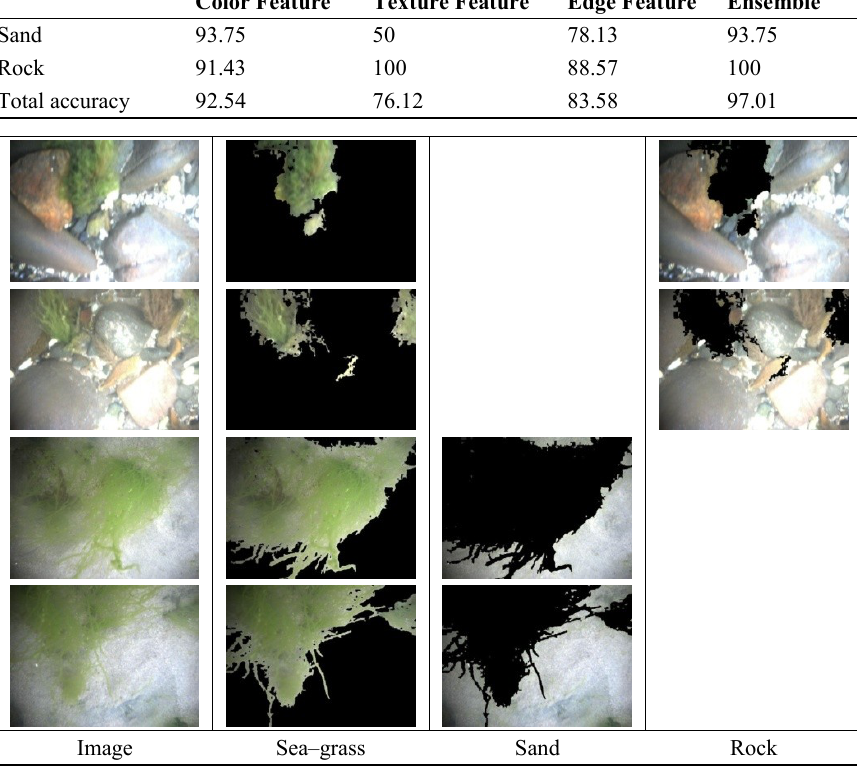
Fig. 6. Separation of test image into sea–grass, sand and